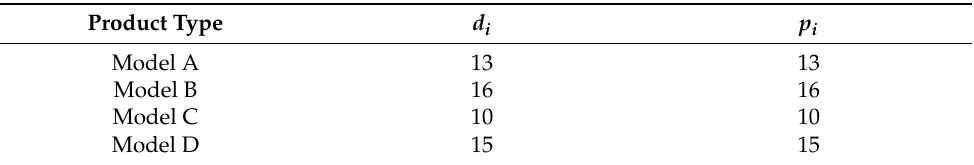
Table 4. Four anonymized product types over a period of 2 months for the present case study.